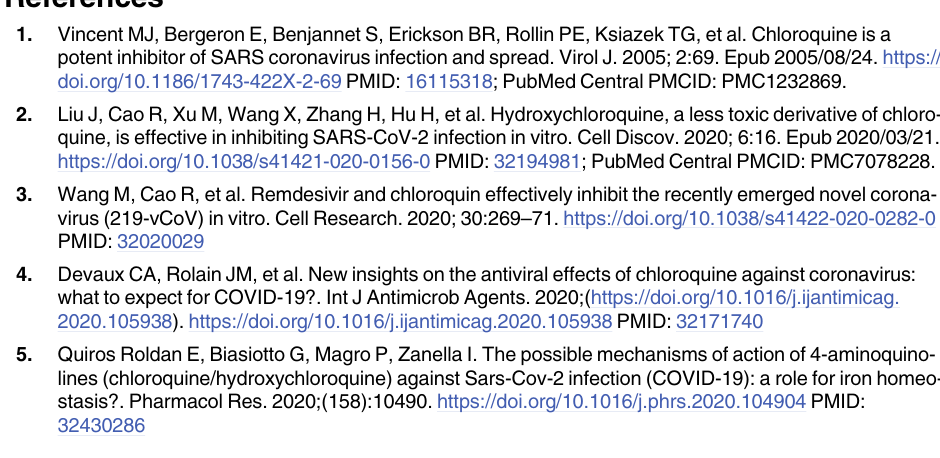
Panel A : IgM levels (MFI). Panel B : IgG levels (MFI). Panel C : IgG levels (%). Panel D : IgG levels (index value). Panel E : IgM and IgG (median index value). Panel F : IgM (index value). (PDF) S6 Fig. The effect of HCQ ad AZ on the cellularity of thymic subsets. Panel A: CD4 MFI on CD4+ thymocytes. Panel B: CD8 MFI on CD8+ thymocytes. Panel C: CD4 MFI on double positive (CD4 and CD8+) DP thymic subsets. Panel D: CD8 MFI on double positive (CD4 and CD8+) DP thymic subsets. Panel E: Percent representation of thymic subsets in response to anti-PD-1, HCQ and HCQ/AZ. Panel F: Medium size representation of thymic subsets in response to anti-PD-1, HCQ and HCQ/AZ. Panel G: HCQ uptake on thymocytes.